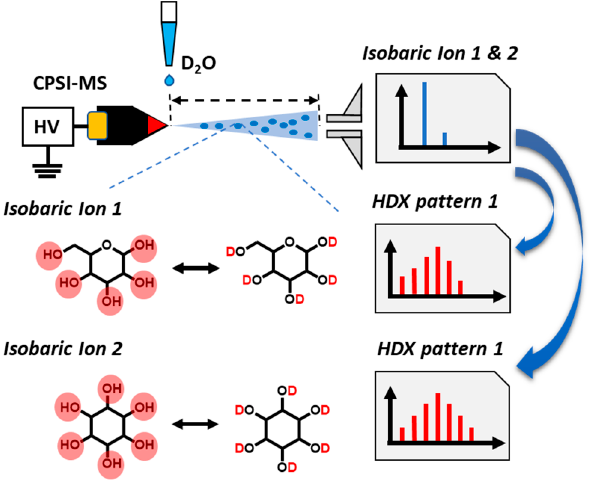
Figure 1. Workflow for using HDX–CPSI-MS for distinguishing between isobaric ions.